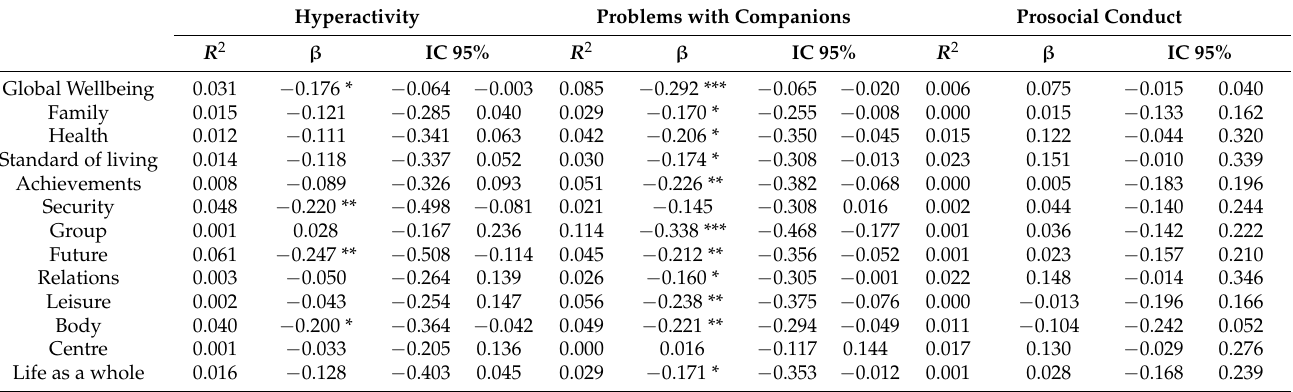
Table 6. Linear regression analysis between the adolescents’ emotional and behavioural difficulties and their personal wellbeing (II).